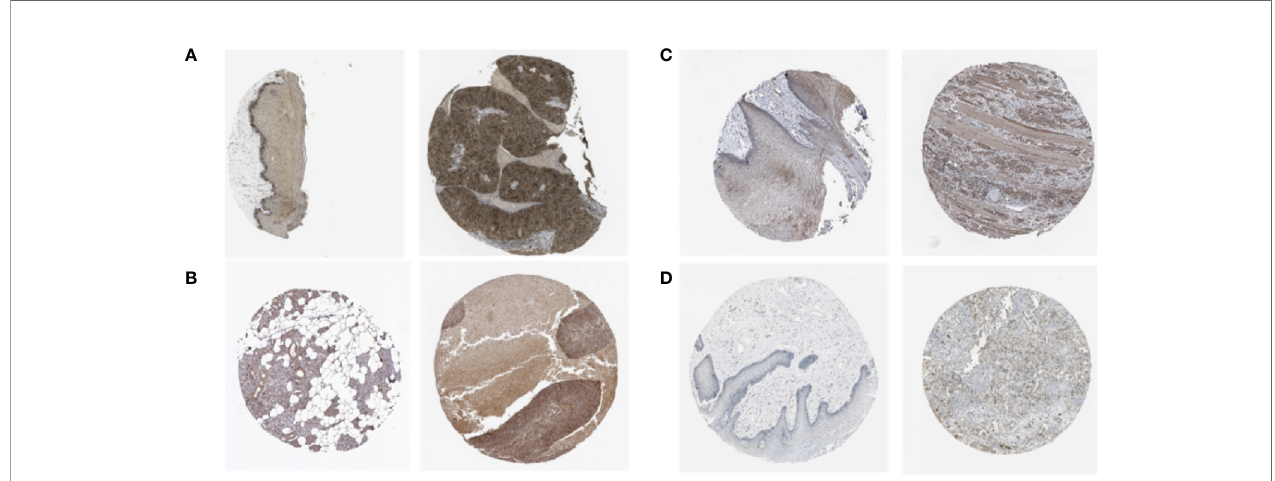
FIGURE 4 | The expression pro fi les of the proteins encoded by TTK (A) , KIF14 (B) , KIF18A (C) and DLGAP5 (D) in normal and HNSCC tissues using clinical specimens from the Human Protein Pro fi les. The left is normal specimens and the right is specimens from HNSCC